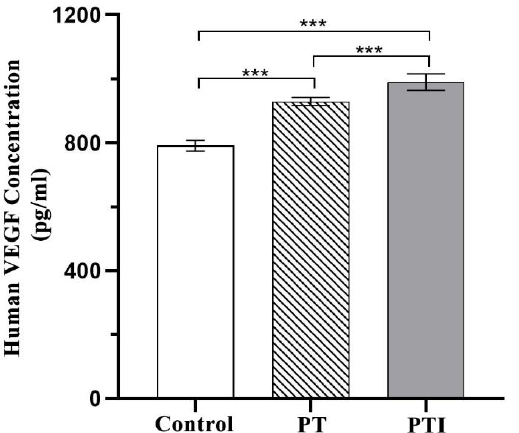
Figure 9. VEGF secretion levels in each group after coculture of cells with scaffolds *** p < 0.001.